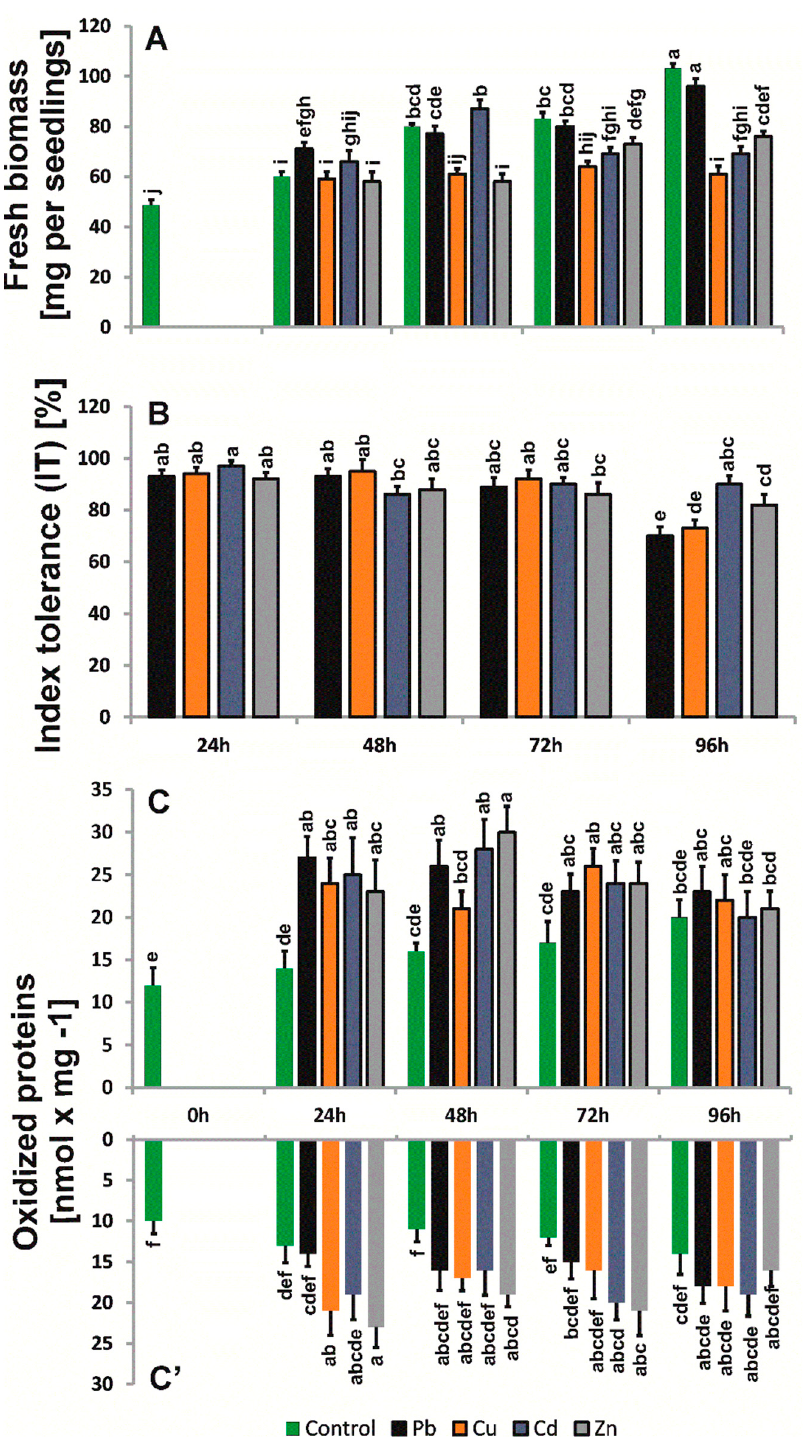
Figure 2. Stress parameters in B. juncea seedlings treated with trace metals: Pb, Cu, Cd, and Zn. The results are expressed as the mean ± standard deviation ( n = 3). Metal solutions Pb(NO 3 ) 2 , CuSO 4 , CdCl 2 , and ZnSO 4 were applied at a 50 μ M concentration. Mean values of three replicates (±SD).